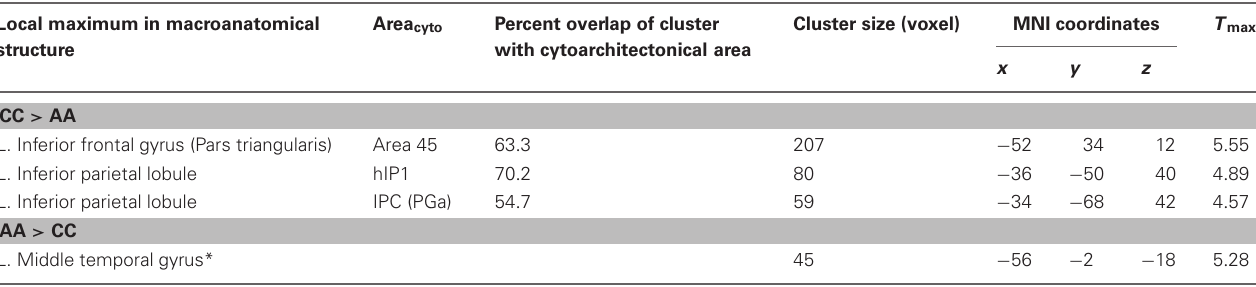
Table 3 | Macroanatomical structure, cytoarchitectonical area (Area cyto ), percent overlap of cluster with cytoarchitectonical area, cluster size in voxel, MNI coordinates ( x , y , z ), and maximum T value ( T max ) of the local maxima from the direct contrasts of concrete noun-verb combinations compared to abstract noun-verb combinations (CC > AA) and vice versa (AA > CC). Local maximum in macroanatomical Area